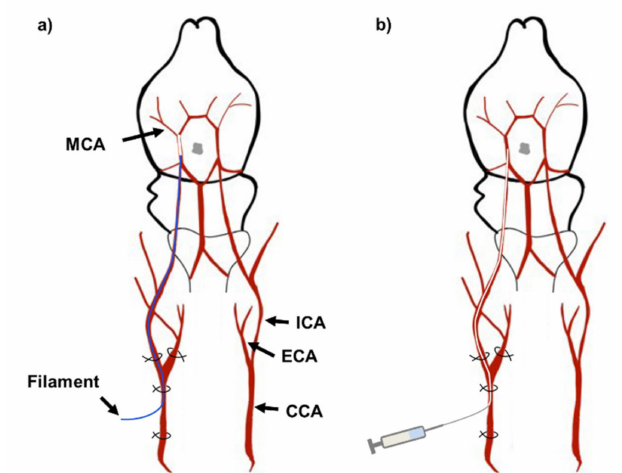
Figure 8. Illustration of middle cerebral artery occlusion and injection. ( a ) Insertion of nylon filament for MCAO. The CCA was ligated permanently while the ECA and ICA were temporarily ligated to stop blood flow. A small incision was made in the CCA for the filament insertion. The silicone-coated filament was inserted until it reached the MCA. The artery was occluded for 90 min. Then the filament was removed for reperfusion; ( b ) Insertion of polyethylene tubing for injection of LE or vehicle. The polyethylene tubing was inserted near to the MCA. After injection, the tubing was removed and the CCA near the bifurcation was permanently ligated. The temporary ligations on the ICA